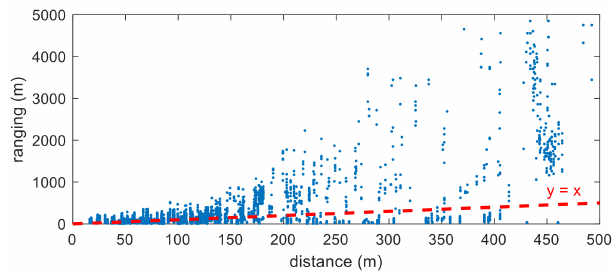
Figure 2. Ranging information converted from RSRP measurements in Figure